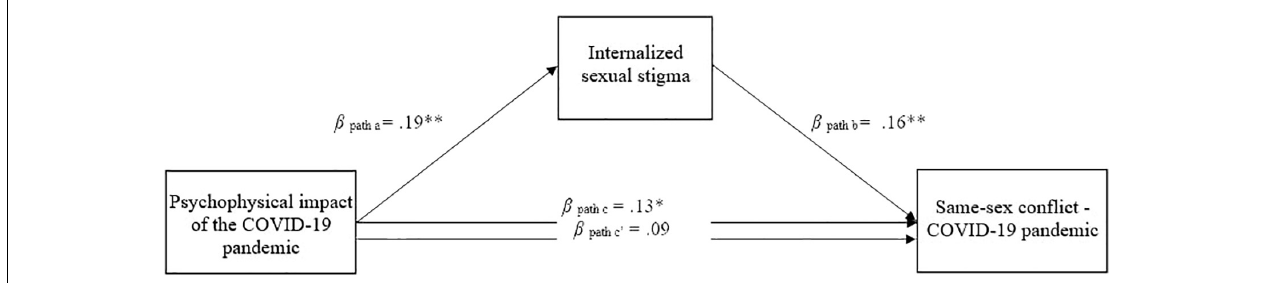
FIGURE 1 | The mediated effect of internalized sexual stigma on the relationship between the psychophysical impact of the COVID-19 pandemic and couples conflict ( n = 232). ∗ p < 0.05, ∗∗ p < 0.1. All values are beta